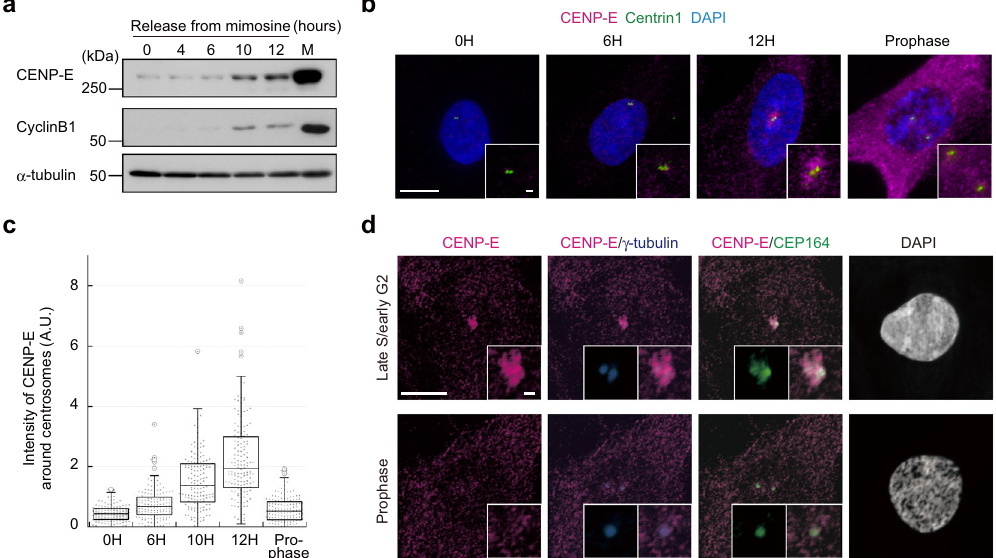
Fig. 1 Cytoplasmic CENP-E is recruited around centrosomes in G 2 phase. a Mimosine synchronized RPE-1 cells were released into fresh media and harvested 0, 4, 6, 10, and 12 h after mimosine removal. M phase cells were synchronized with monastrol. Total cell lysates were immuno-blotted with indicated antibodies. b RPE-1 cells released from mimosine were immuno-stained with antibodies against CENP-E (magenta) and centrin1 (green). Representative pictures 0, 6, and 12 h after release or in prophase are shown (scale bar = 10 μ m). Inset in each panel is a magni fi ed image around centrosomes (scale bar = 1 μ m). c Signal intensities of CENP-E around centrosomes in b were measured and plotted ( N = 148, two independent experiments; whisker: 95% con fi dence interval; box: interquartile; center line: median). d Representative images for z-stacks around centrosomes in late S/ early G 2 (top) or prophase (bottom) wild-type cells co-stained for indicated markers (scale bar = 10 μ m). Inset in each panel is a magni fi ed image around centrosomes (scale bar = 1 μ